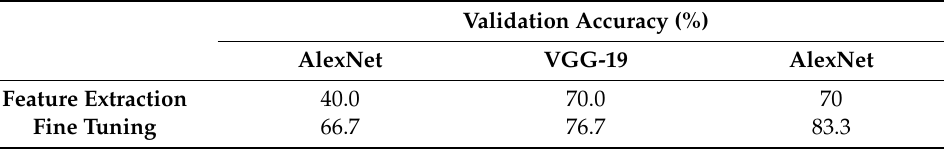
Table 8. Validation accuracy results of the three proposed DCNNs, with custom vine plants images from Chatzivariti’s winery